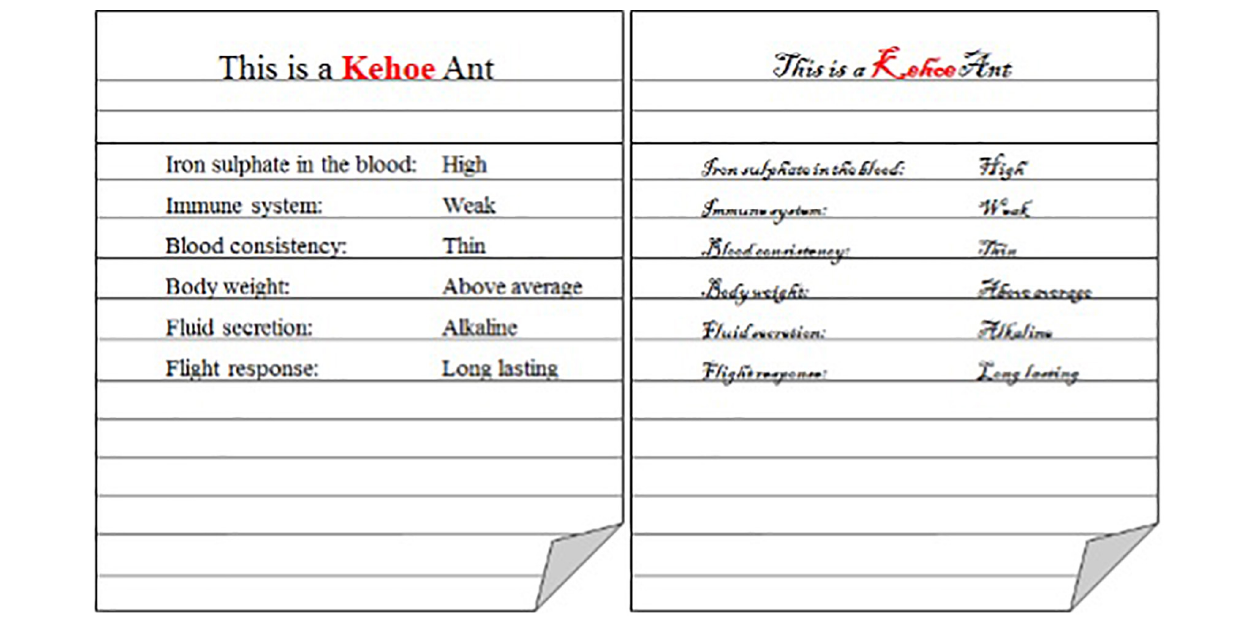
FIGURE 4 | Example exemplar in the fluent (left) and disfluent (right) font